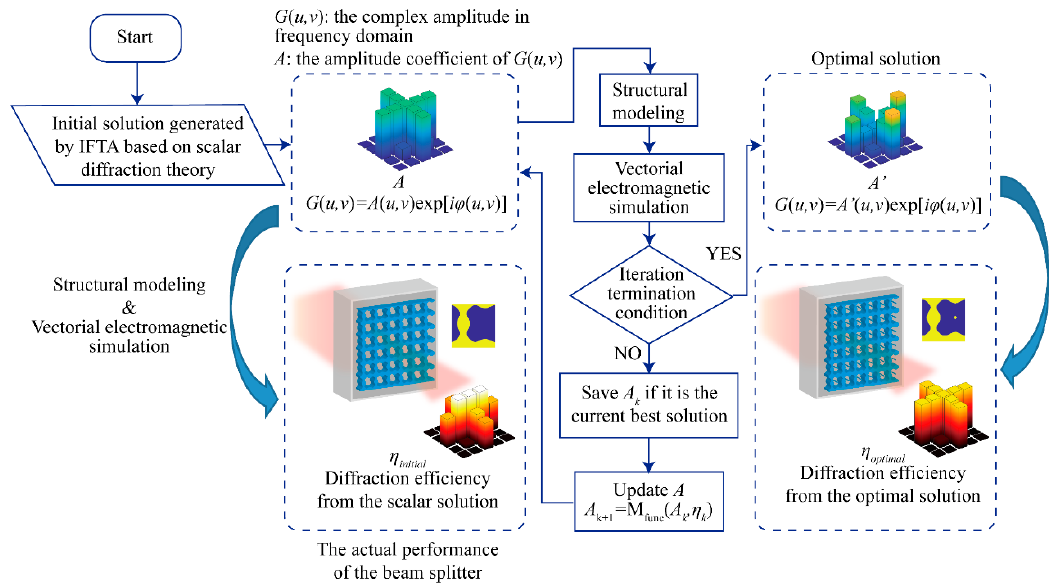
Figure 1. Schematic of the proposed vector IFTA. The flow chart of the optimization algorithm is illustrated combining with the design example of a beam splitter with a cross-shaped diffraction pattern, and each diffraction order is expected to have equal intensity.